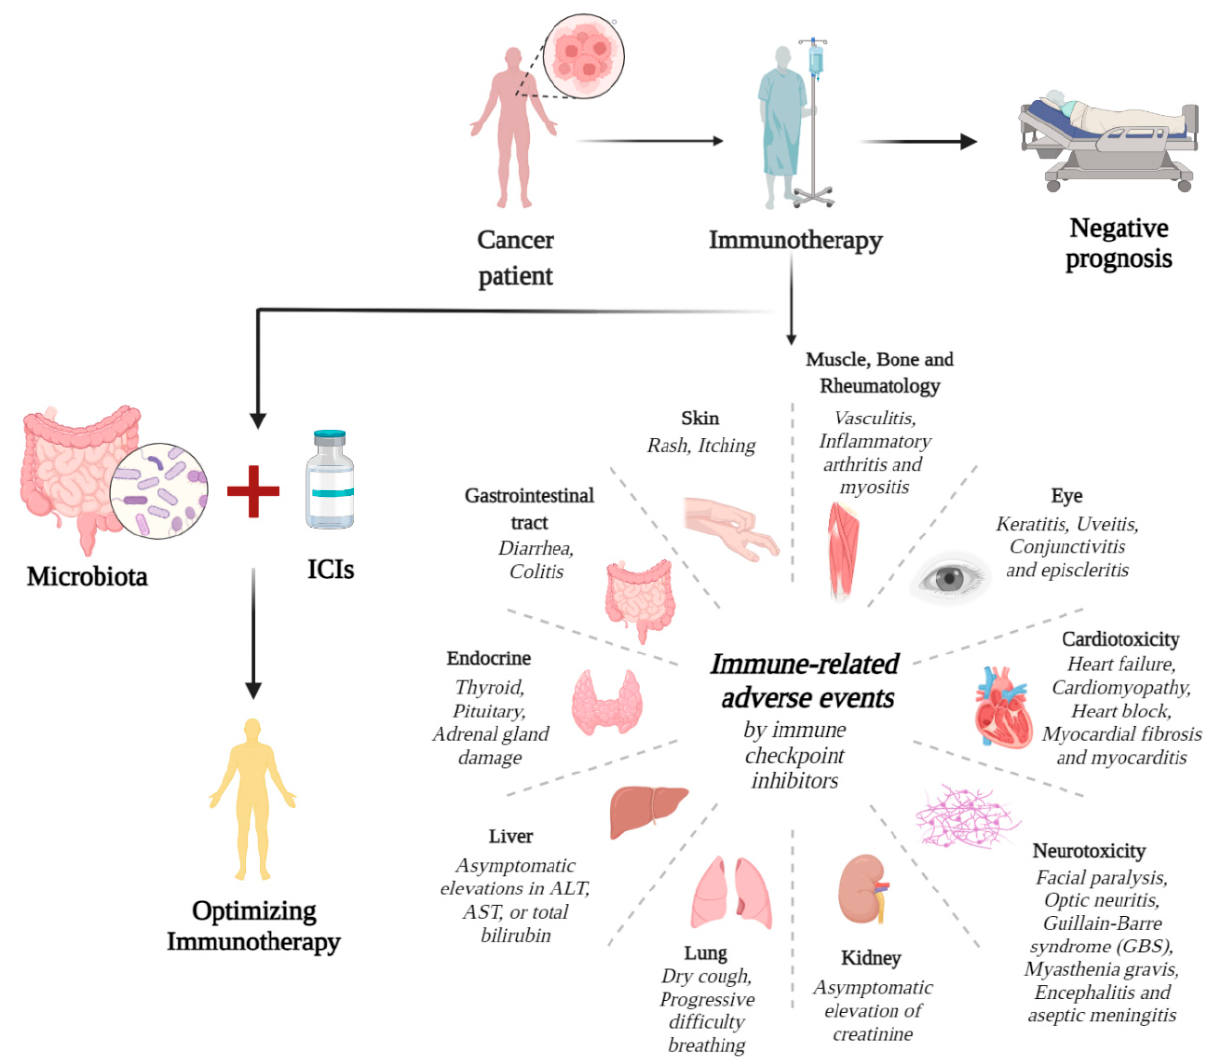
Figure 1. Immune-related adverse events of various organs or tissues caused by cancer immunotherapy. The immune adverse events mainly involved the skin, gastrointestinal tract, endocrine glands, liver, lungs, kidneys, nerves, heart, eyes, and musculoskeletal. The addition of the gut microbiota is expected to optimize the efficacy of cancer immunotherapy. Table 2. Common immune ‐ related adverse events.